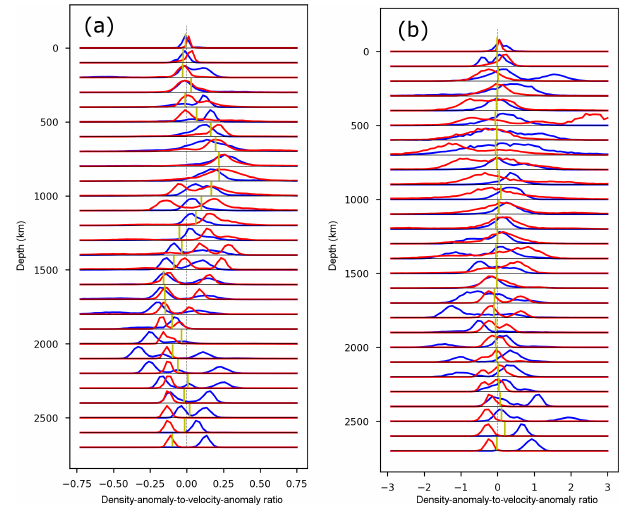
Figure 9. Distribution of density-anomaly-to-velocity-anomaly ra- tios as a function of depth. The blue line is the distribution for fast velocity anomalies, and the red line is for slow velocity anomalies. The yellow line gives the median of the ratio distribution. Note that the median sometimes appears to lie outside the distribution, which is due to heavy tails that are not visible on this scale. Furthermore, the histograms for slow and fast anomalies are scaled to have the same maximum height for easier visual comparison. (a) Scaling for results with isostatic residual. (b) Scaling for results with crustal